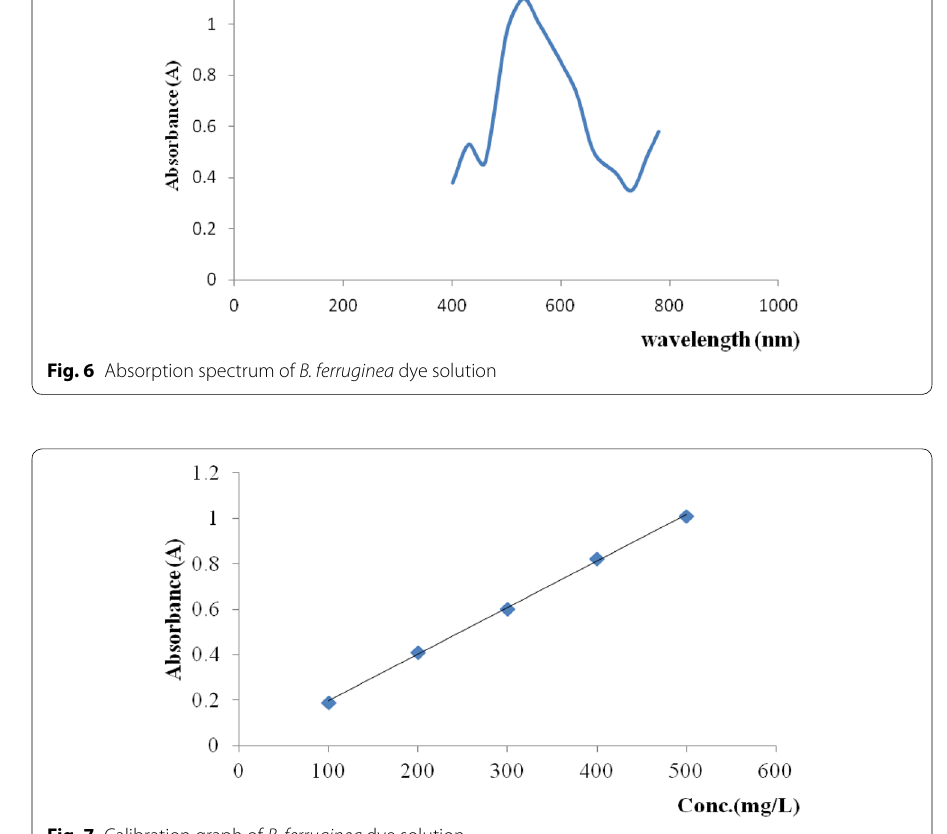
Fig. 7 Calibration graph of B. ferruginea dye